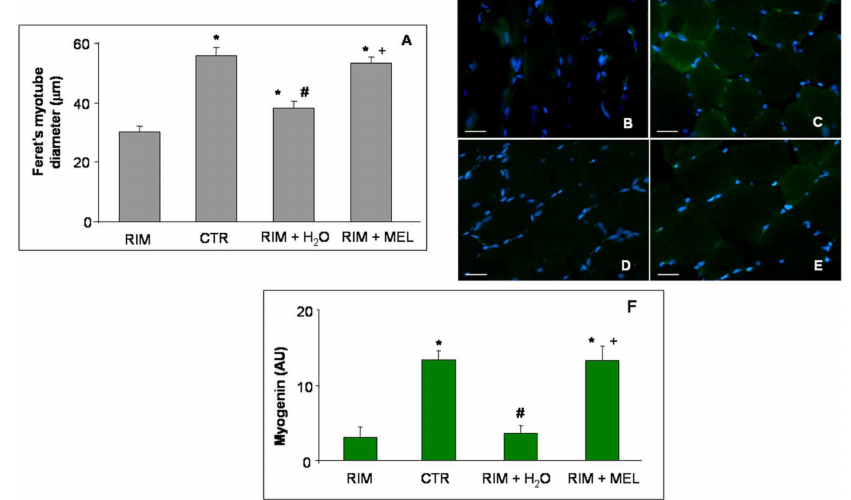
Figure 2. Myotube diameter and myogenin expression. The graph ( A ) shows the analyses of Feret’s myotube diameter of gastrocnemius skeletal muscle, expressed in µ m. The immunofluorescence photomicrographs ( B – E ) show the gastrocnemius skeletal muscle myogenin expression of RIM rats ( B ), control rats ( C ), RIM rats plus tap water ( D ), and RIM rats supplemented with melatonin ( E ). Bar equal: 20 µ m. Graph ( F ) summarizes the immunomorphometrical measurement of myogenin immunopositivity. * p ≤ 0.05 vs. RIM; # p ≤ 0.05 vs. CTR; + p ≤ 0.05 vs. RIM + H 2 O. CTR: control; H2O: tap water; MEL: melatonin; RIM: reserpine-induced